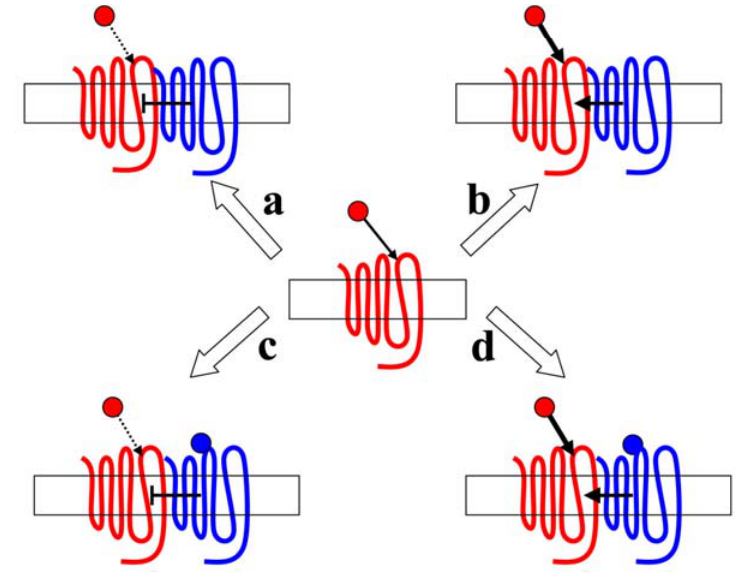
FIGURE 3. Intramolecular interactions in the receptor heterodimer. The affinity of a given ligand for its receptor (central drawing) may decrease (a) or increase (b) when the receptor forms heterodimers and also may be decreased (c) or increased (d) when the receptor partner (in the heterodimer) is occupied by the same (for isoreceptors) or another